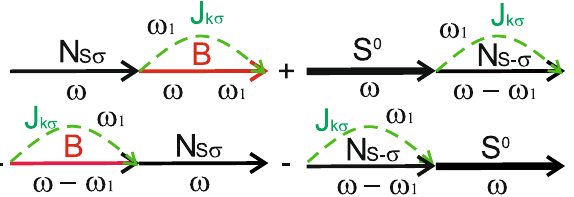
Figure 5. Diagrams contributing to the tunneling current through the S